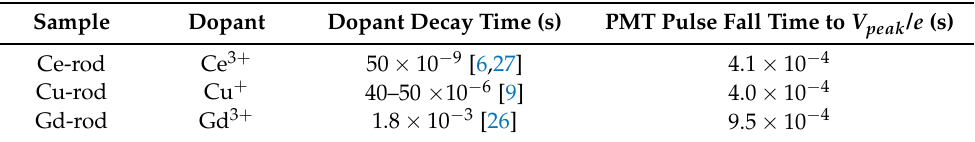
Table 2. Time structure of the pulses from the